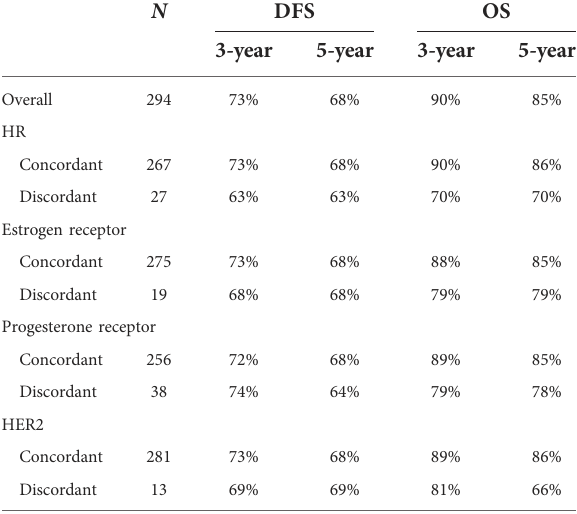
TABLE 4 Relationship between changes in pathological markers and 3- and 5-year OS and DFS